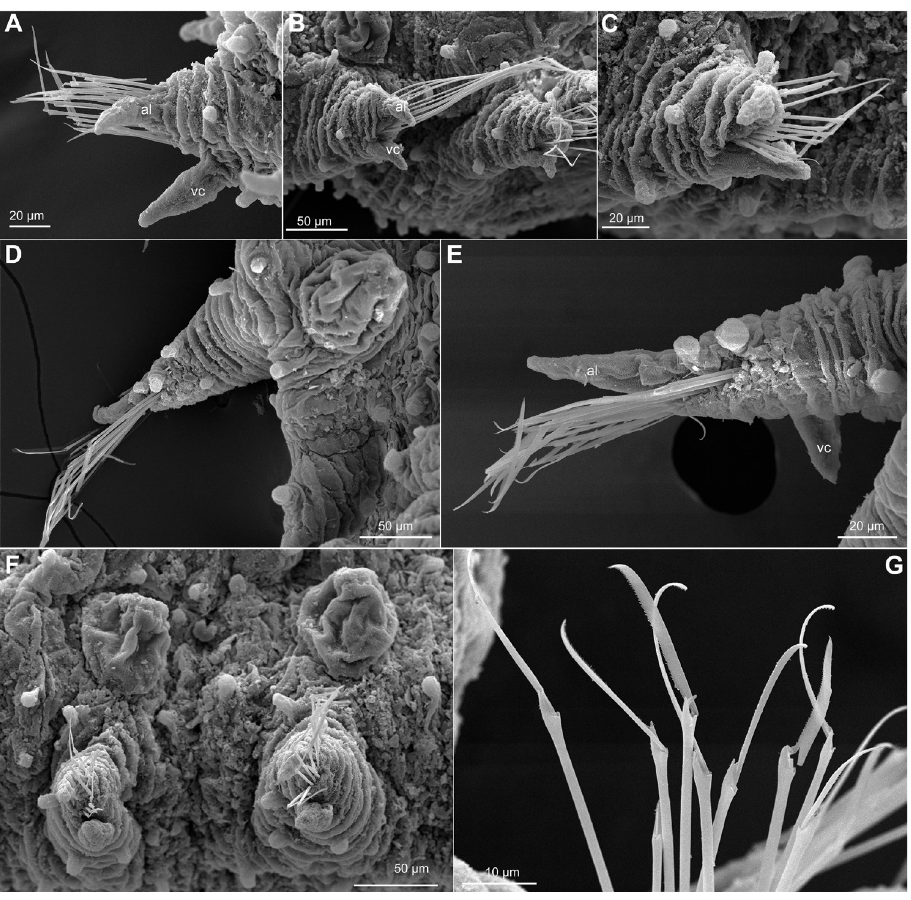
Figure 9. Sphaerodoropsis corrugata , USNM 1002193 and 1002207. A Parapodium first chaetiger, ante- rior view B Parapodia chaetiger 6 and 7, anterior view C Posterior parapodium, anterior view D, E Mid- body parapodia, dorsal view F Mid-body segments, side view G Mid-body chaetae. Abbreviations: al, acicular lobe; vc, ventral